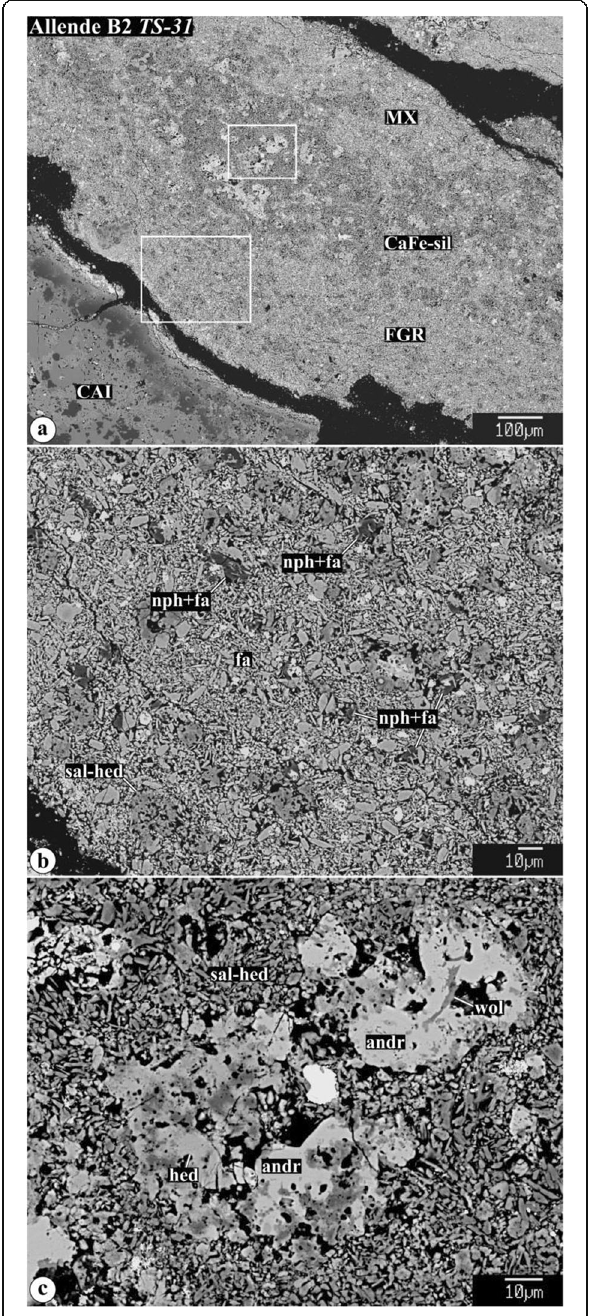
Fig. 2 Backscattered electron images of a fine-grained matrix-like rim and a Ca,Fe-rich silicate layer around Type B2 CAI TS31 . The matrix-like rim consists predominantly of lath-shaped ferroan olivine, nepheline, and salite-hedenbergite pyroxene nodules. The Ca,Fe-rich silicate layer is composed of salite-hedenbergite pyroxenes, andradite, and